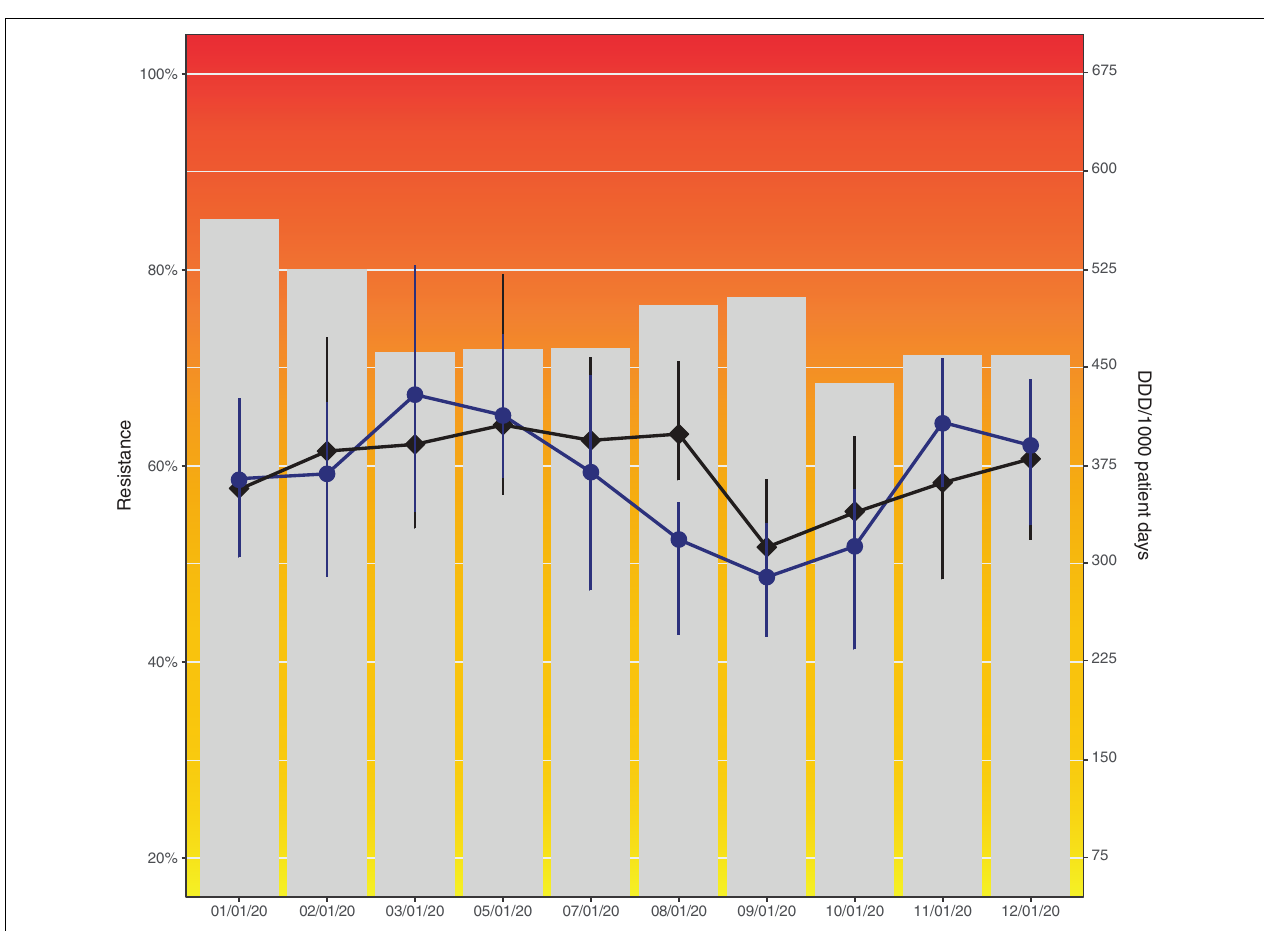
FIGURE 4 | Resistance to amoxicillin in Escherichia coli and consumption of cefuroxime (black) and piperacillin/tazobactam (blue) across hospital departments in 2020. This data visualization (simulated data) shows several problems identified in this study: Axes not starting at zero, use of double y -axes, background colors, hidden data points by overlaps, color scheme mismatch (blue and black difficult to distinguish), unequal axis steps on x -axis, missing legend, incomplete axis labels (abbreviation not